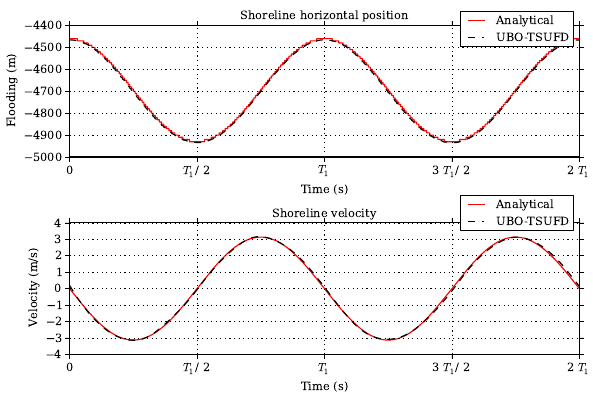
Fig. 11. Benchmark n. 2: coastline position and velocity predicted by UBO-TSUFD (black dashed line) compared to the analytical so- lution (red solid line). The agreement is so good that curves are almost